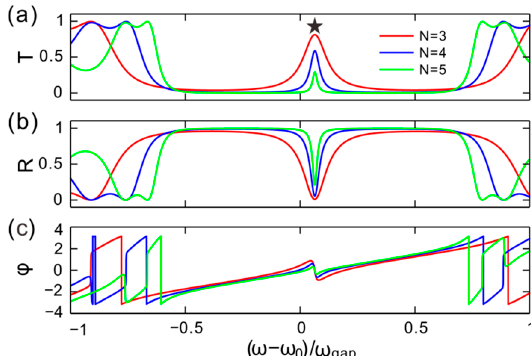
Figure 3. The calculated spectra for the defective photonic crystals (PCs) incorporated with graphene. ( a ) The transmission spectrum T . ( b ) The reflection spectrum R . ( c ) The phase of the reflection coefficient. The chemical potential was μ c = 0.15